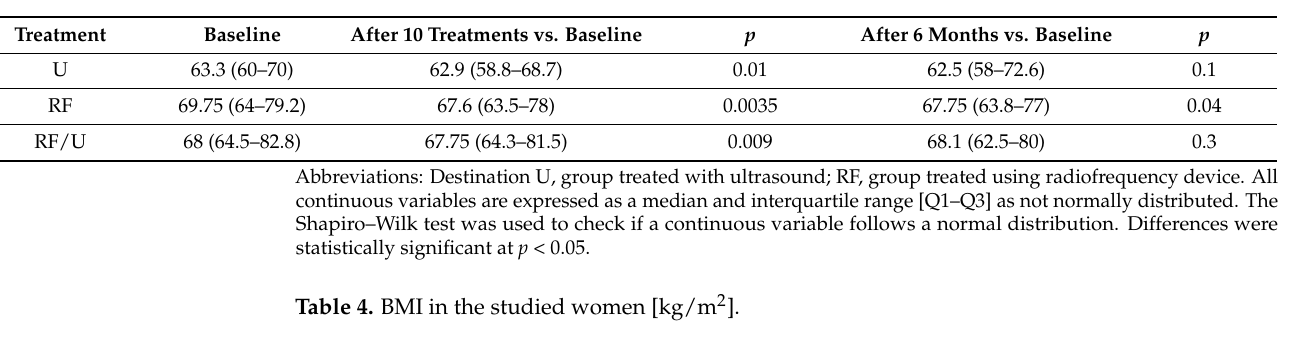
Table 3. Body weight of the studied women [kg].